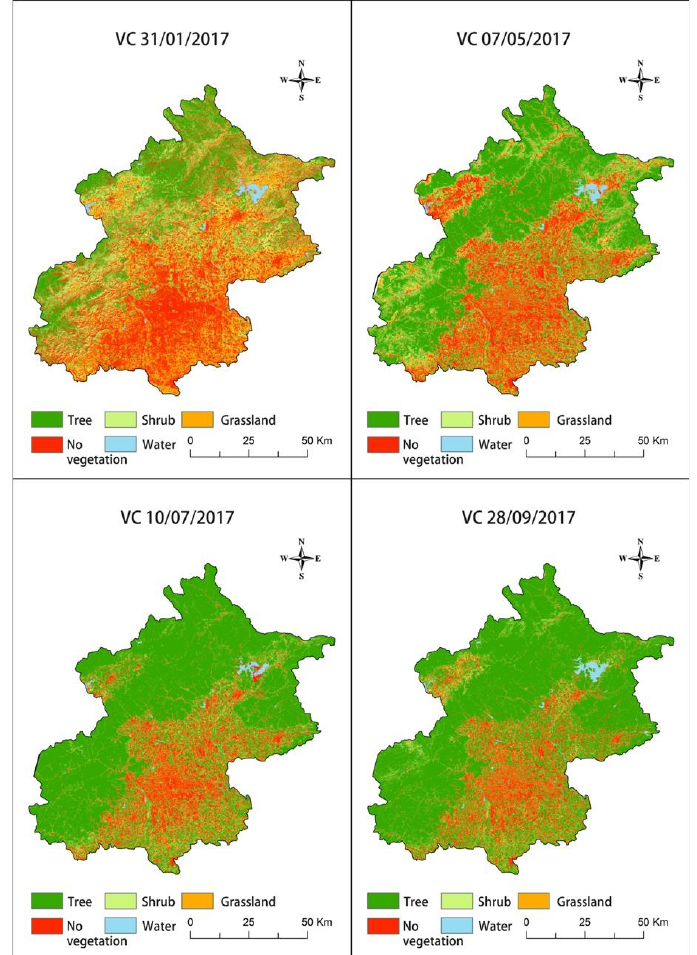
Figure 3. The VCs of Beijing: 31 January 2017, 7 May 2017, 10 July 2017, and 28 September 2017.